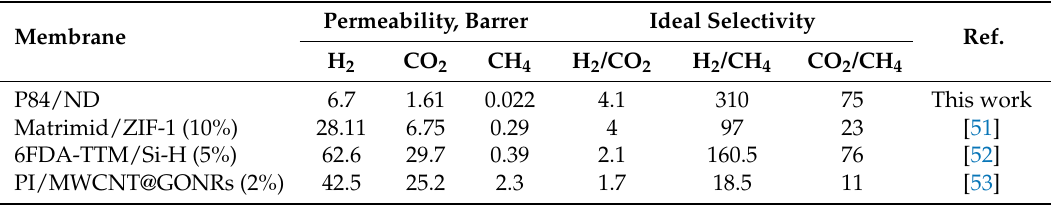
Table 5. Gas transport properties of modified polyimide